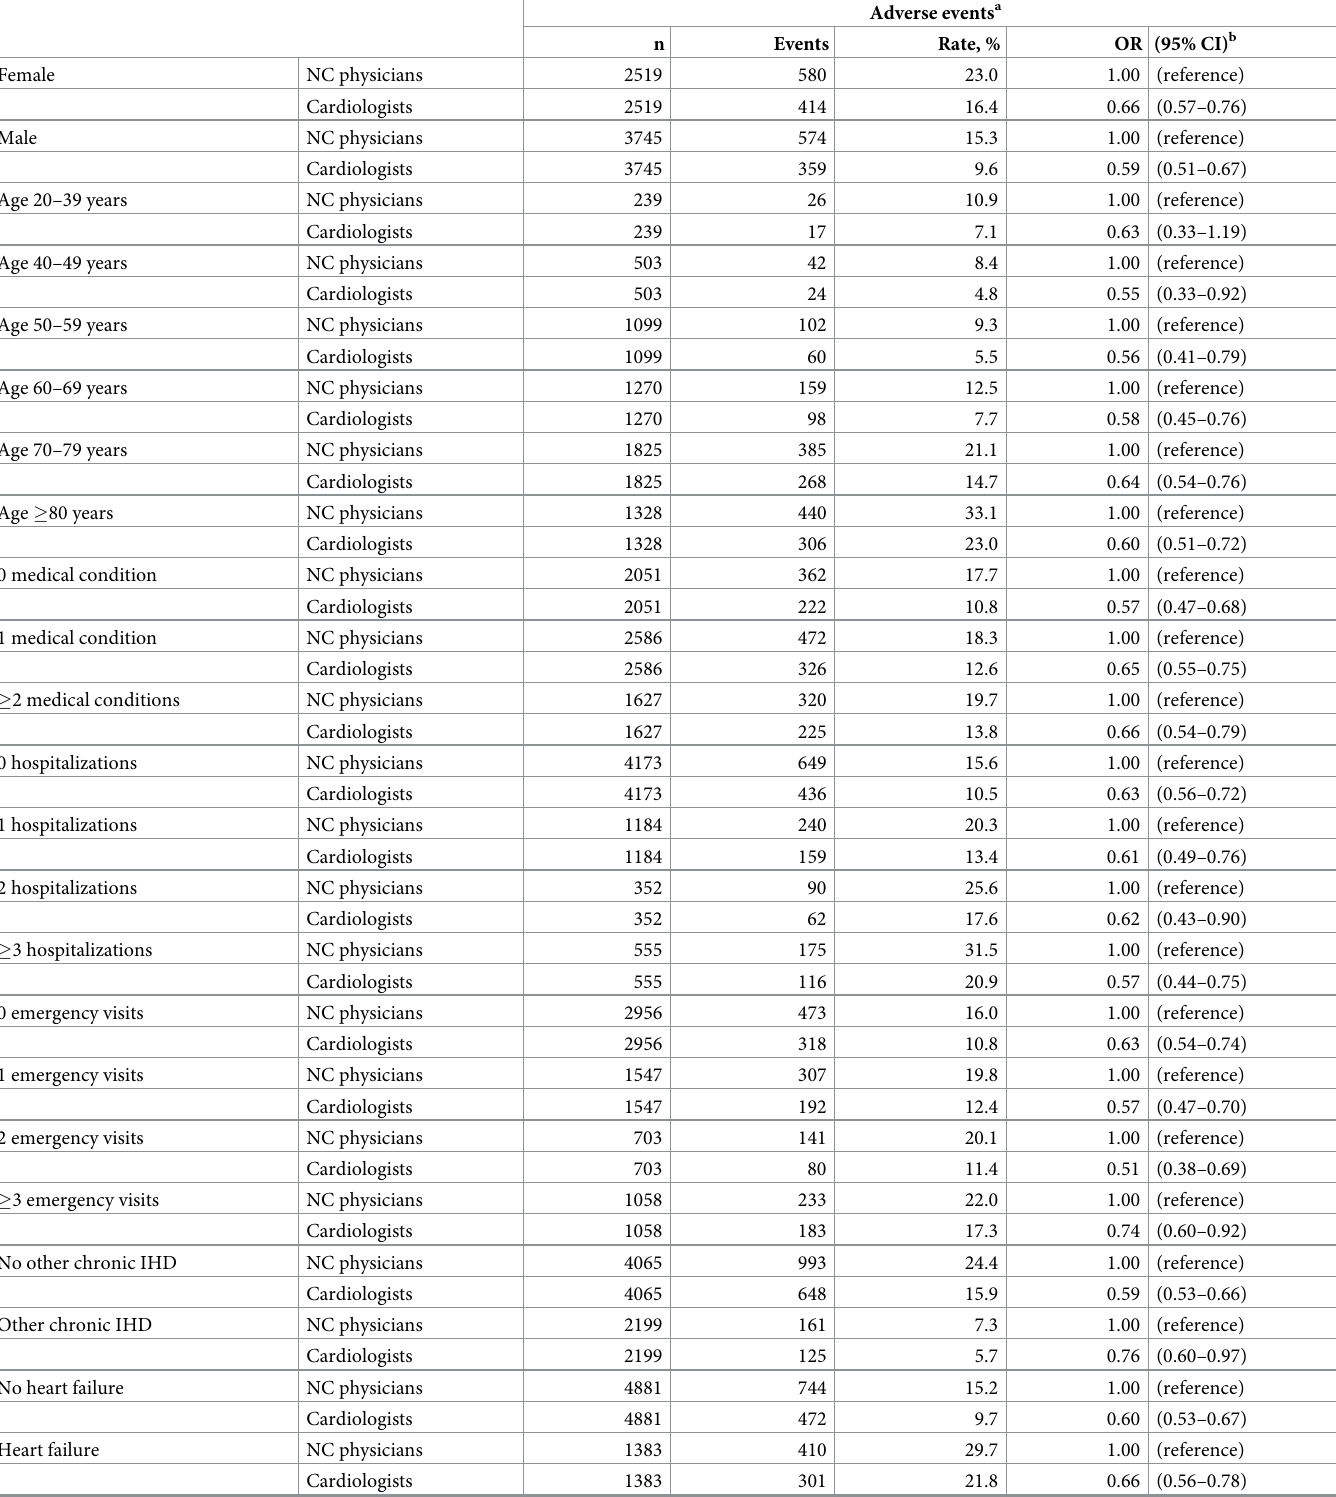
Table 3. The stratified analysis for the adverse events after admission of heart disease associated with cardiologists’